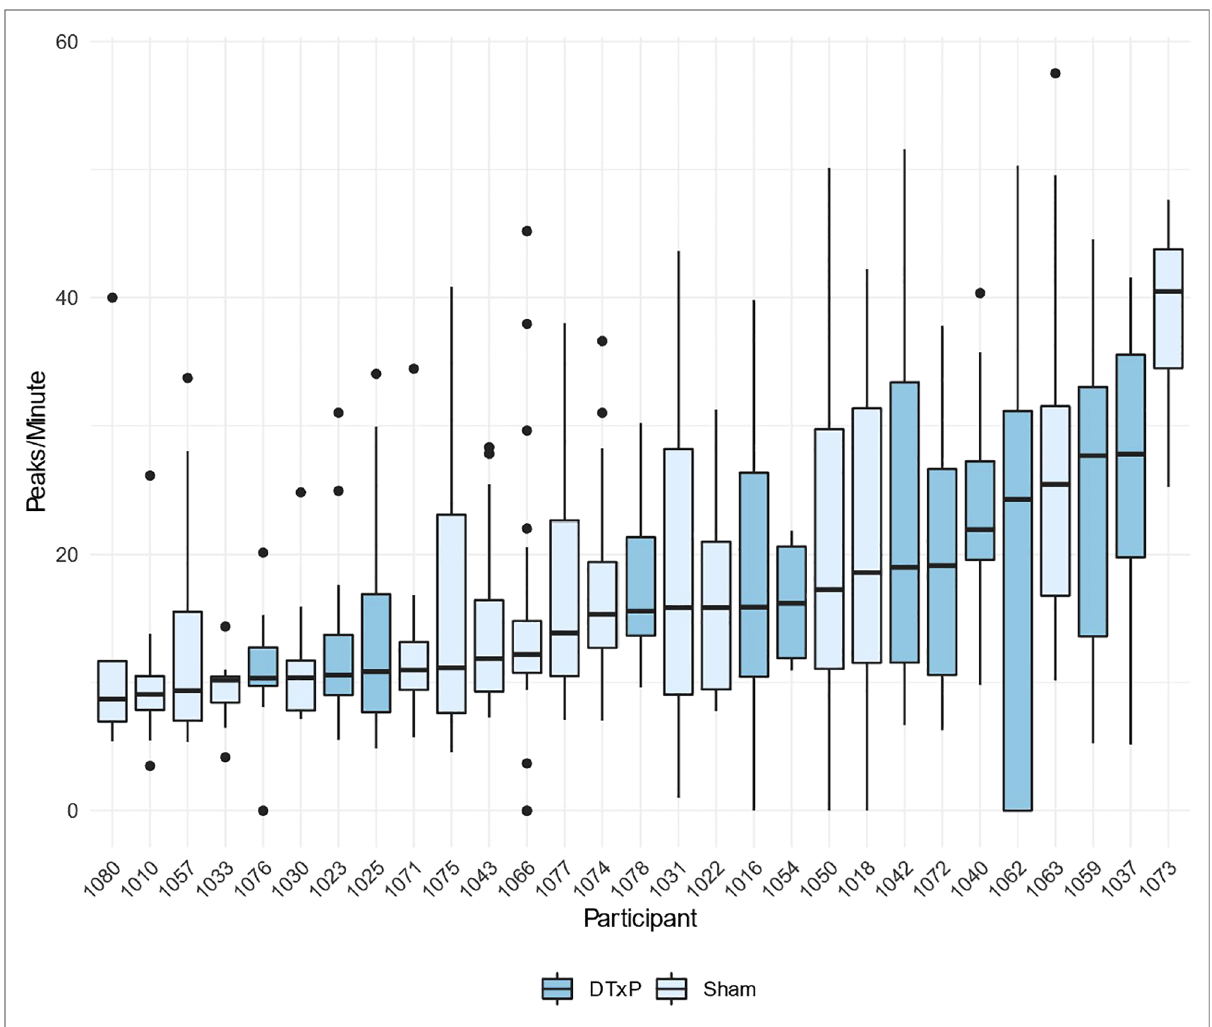
FIGURE 7 Number of electrodermal activity (EDA) peaks per minute by participant, organized in the ascending order by the